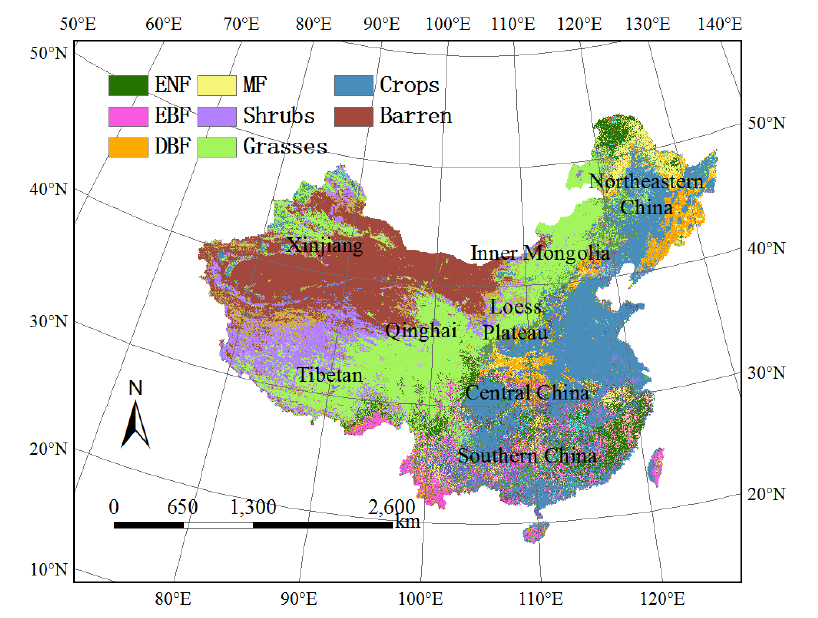
Figure 1. Vegetation distribution in China. ENF, evergreen needle forest; EBF, evergreen broadleaf forest; DBF, deciduous broadleaf forest; MF, mixed